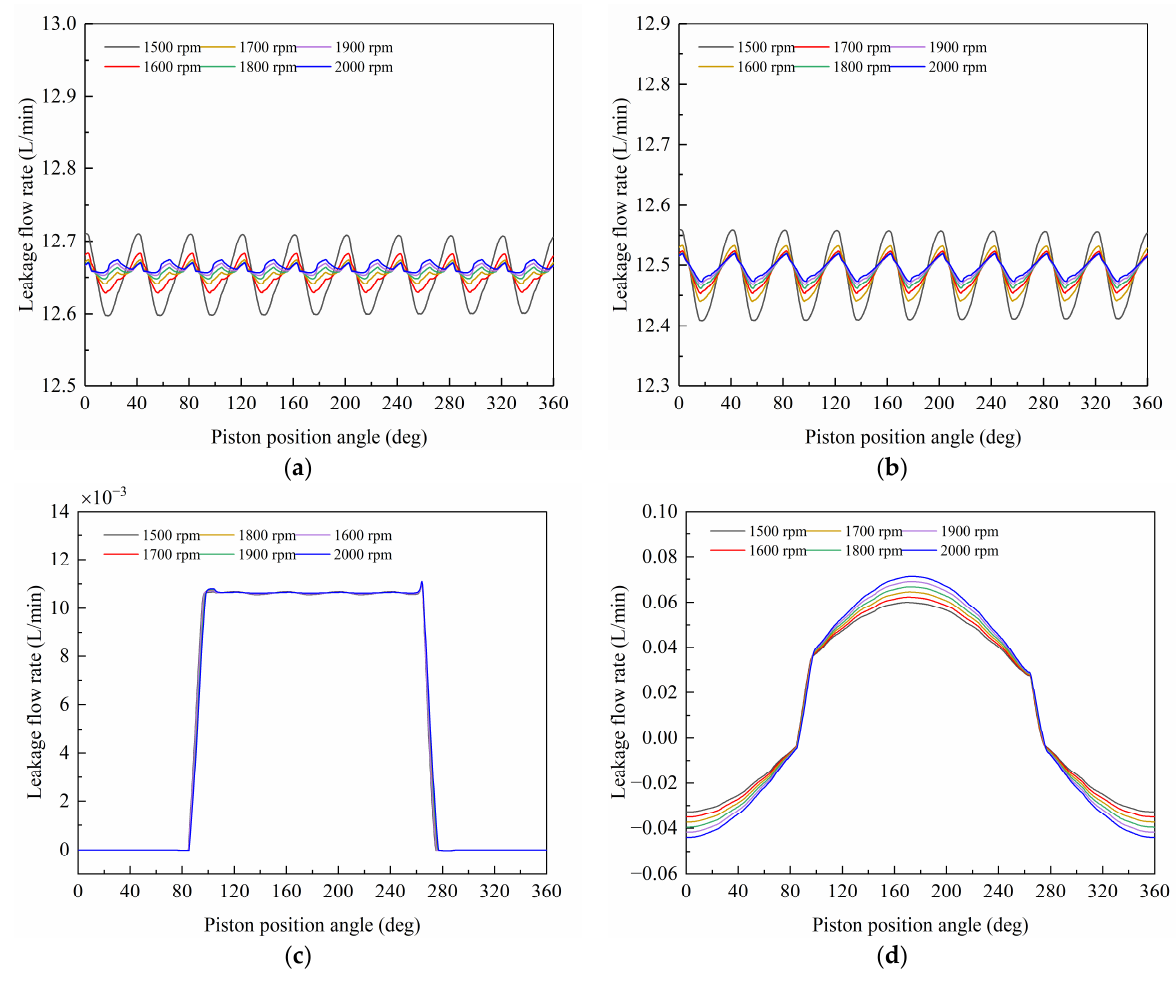
Figure 28. Leakage flow of the piston pump and kinematic pairs under different spindle speeds: ( a ) leakage flow rate of the piston pump; ( b ) leakage flow rate of the port plate–barrel block pair; ( c ) leakage flow rate of the slipper–swash plate pair; ( d ) leakage flow rate of the piston–barrel block pair.